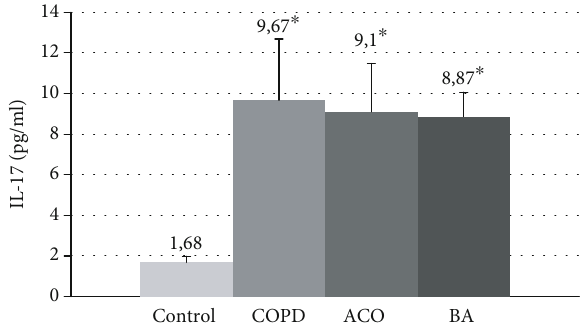
Figure 2: The mean IL-17 concentrations in the blood serum in patients with COPD, asthma-COPD overlap, and bronchial asthma. COPD: chronic obstructive pulmonary disease; ACO: asthma-COPD overlap; BA: bronchial asthma; ∗ p < 0 : 05 versus healthy